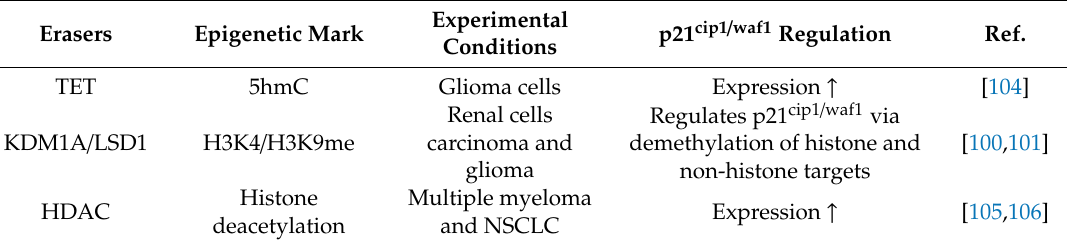
Table 2. Overview of p21 cip1 / waf1 regulation by epigenetic